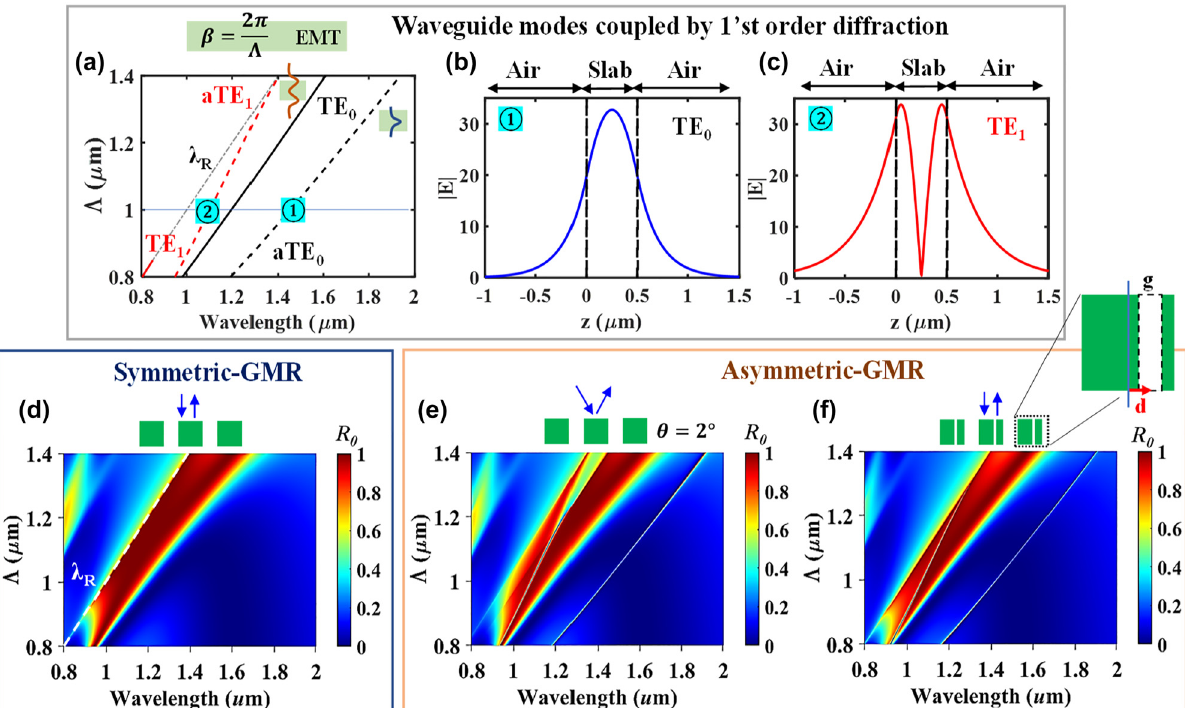
Figure 3: Analysis of phase matching to resonant states in symmetric and asymmetric optical lattices with n = 2. (a) Mode loci in the equivalent lattice homogenized by the Rytov EMT and thus becoming a slab waveguide. At points of ① and ② , with Λ = 1 μ m, transverse profile of | E | is calculated and (c) TE mode shapes. The R ( 𝜆, Λ ) maps for (d) 𝜃 = 0 ◦ , (e) 𝜃 = 2 ◦ and (f) asymmetric geometry at 𝜃 = 0 ◦ exhibit s-GMR and a-GMR showing (b) TE 0 1 0 features. In (f), the square rod is sliced by an air gap ( g = 0.05 μ m) where the distance between centers of rod and air gap is d = 0.05 μ